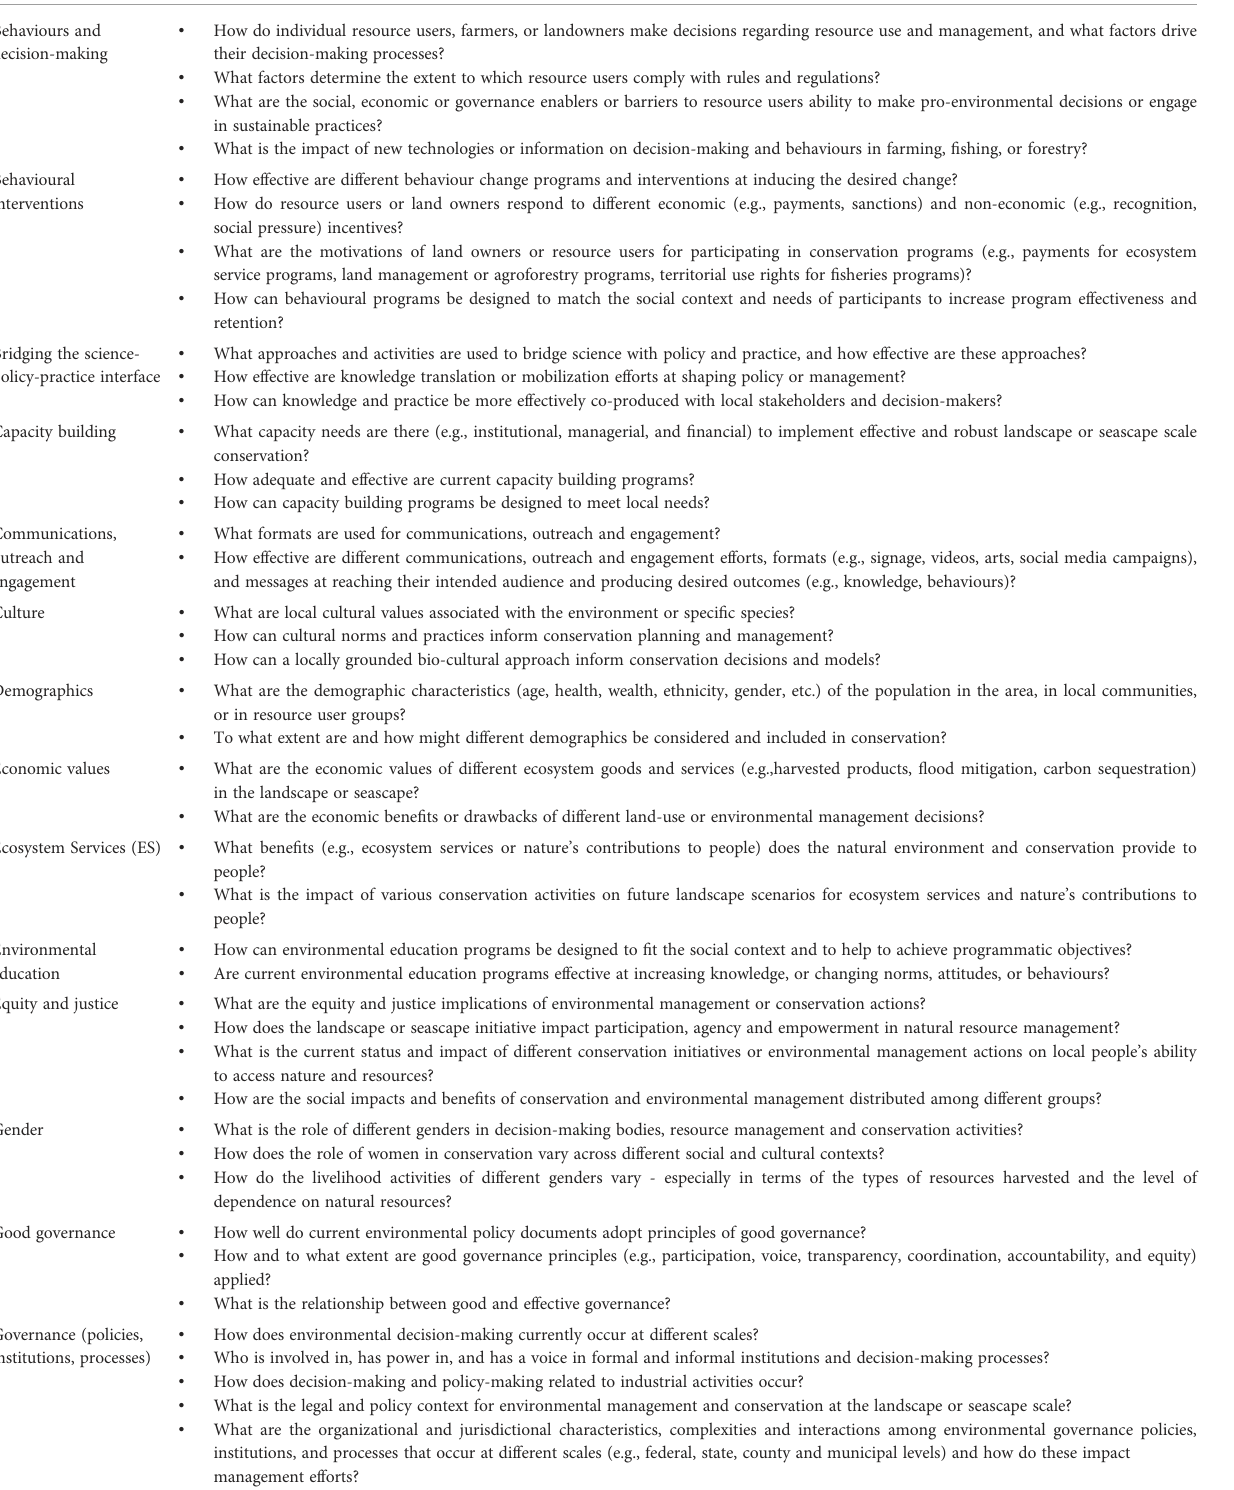
TABLE 3 Potential questions linked to key social science topics related to conservation in working landscapes and seascapes (topics are listed alphabetically, questions were identi fi ed from key informant interviews). Topic Potential research questions related to